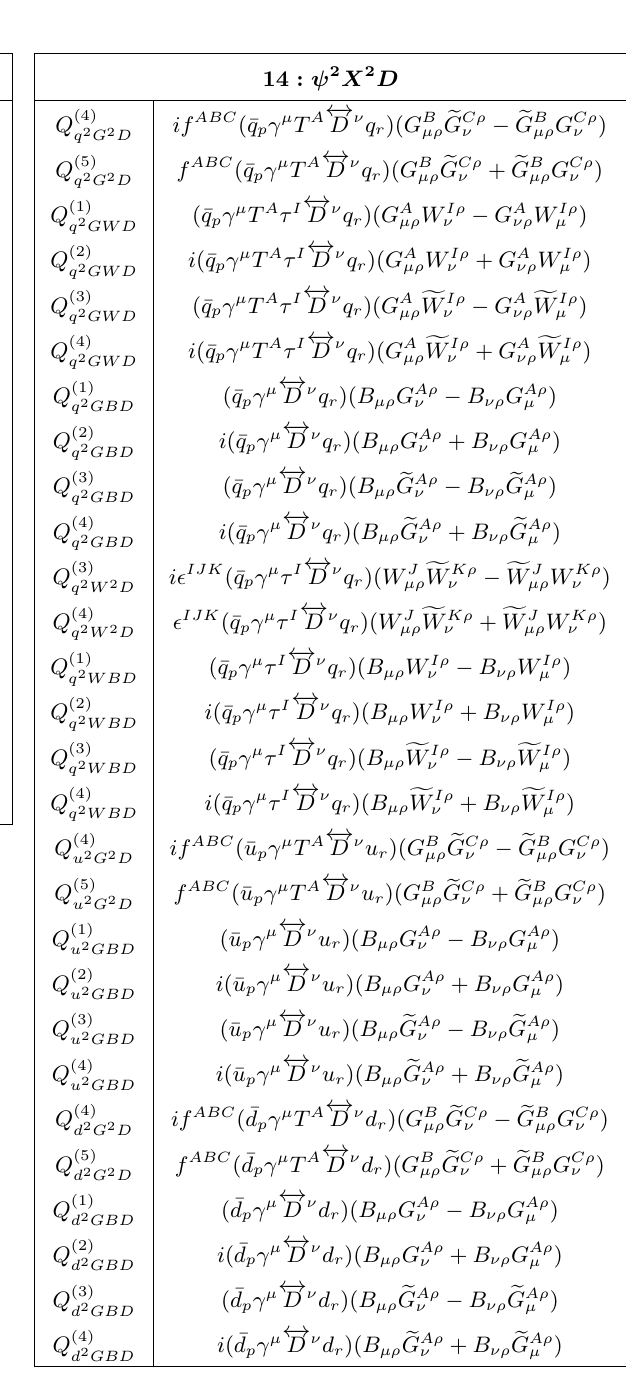
Table 6 . The hadronic dimension-eight operators in the SMEFT of class-14. The subscripts p; r are weak-eigenstate